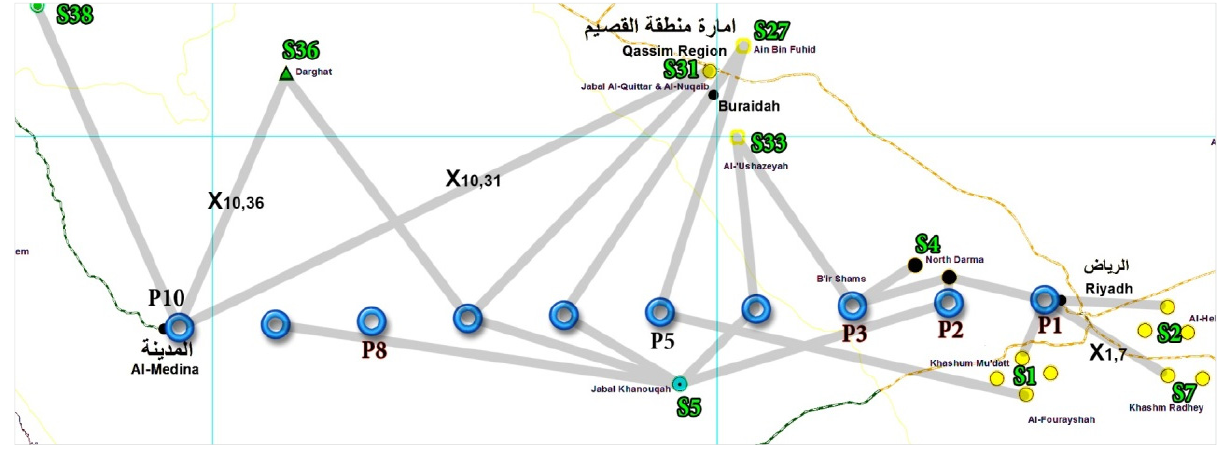
Figure 5. Project nodes WSTs ( P j ), SPLs ( S i ), and their decision variables ( X ji ) [45]. Considering the decision variables ( X ji lines colored grey) between material SPLs